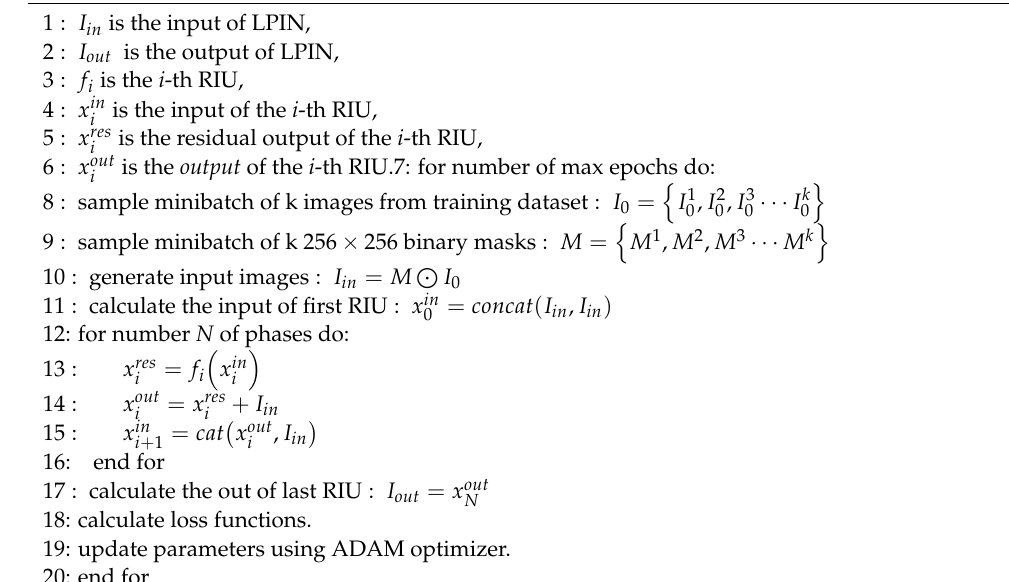
Algorithm 1. The training process of LPIN.